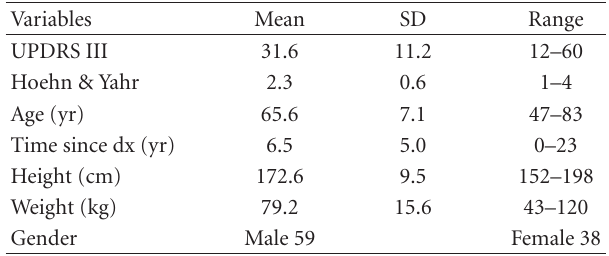
Table 1: Participant